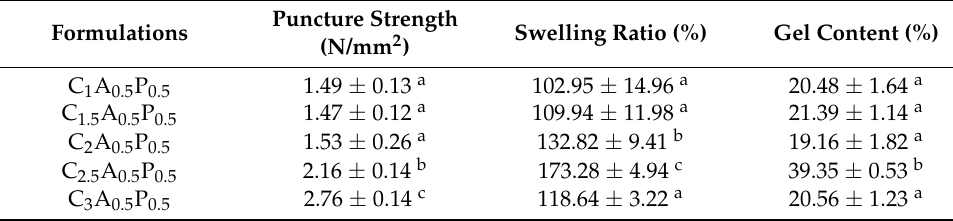
Table 2. Puncture strength, swelling, and gel content of hydrogel.